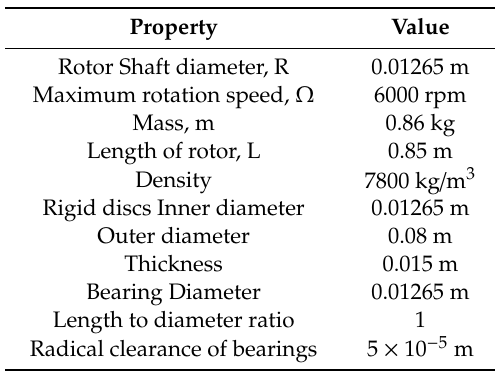
Figure 1. Rotor bearing system. Table 1. The parameters of the test rig.